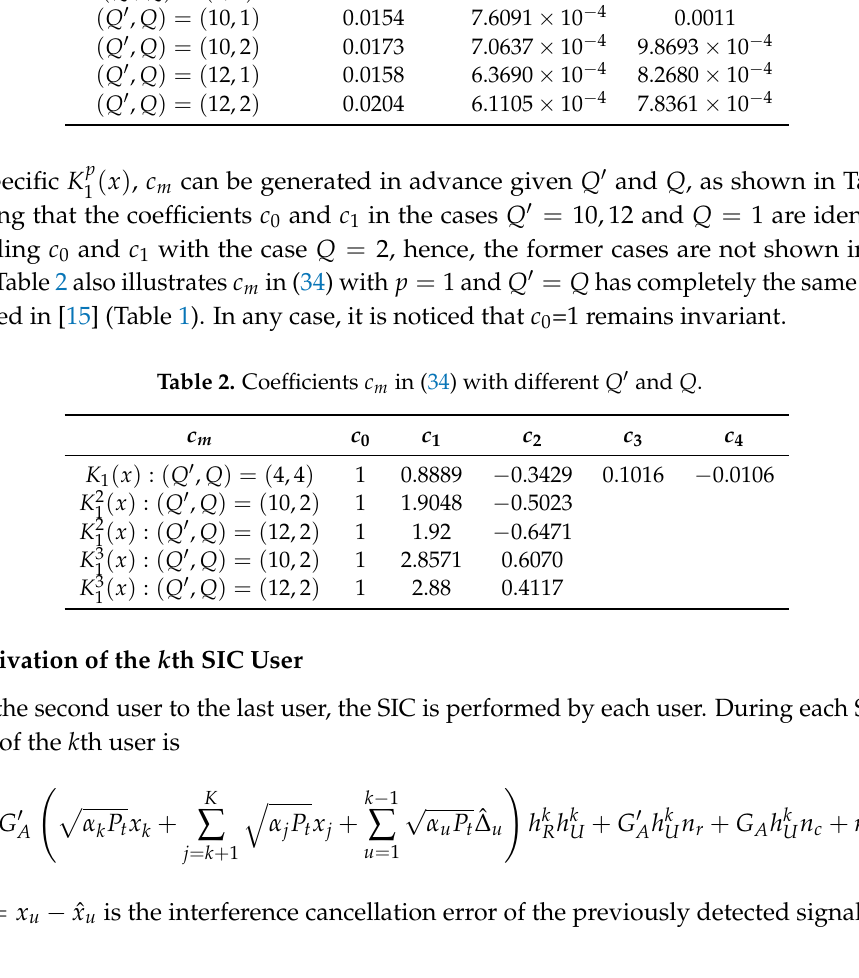
( x ) with different choices of Q (cid:48) and Q . 1 ( x ) K p 1